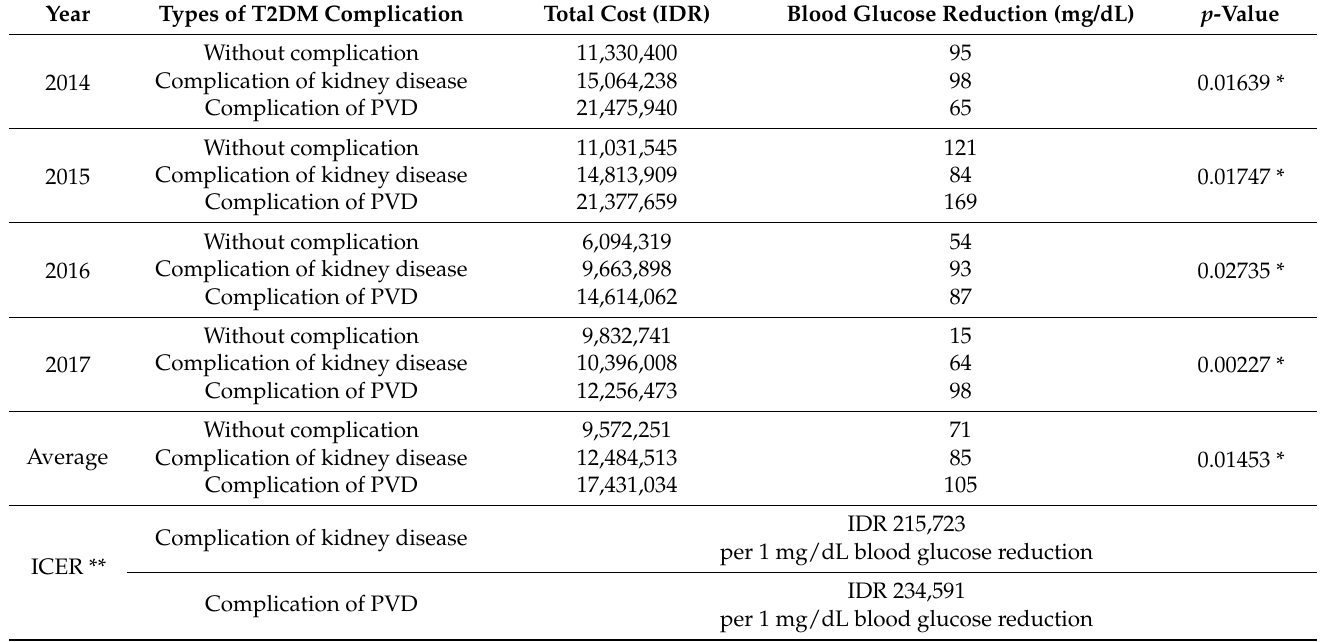
Table 4. Cost-effectiveness value from the perspective of payer.